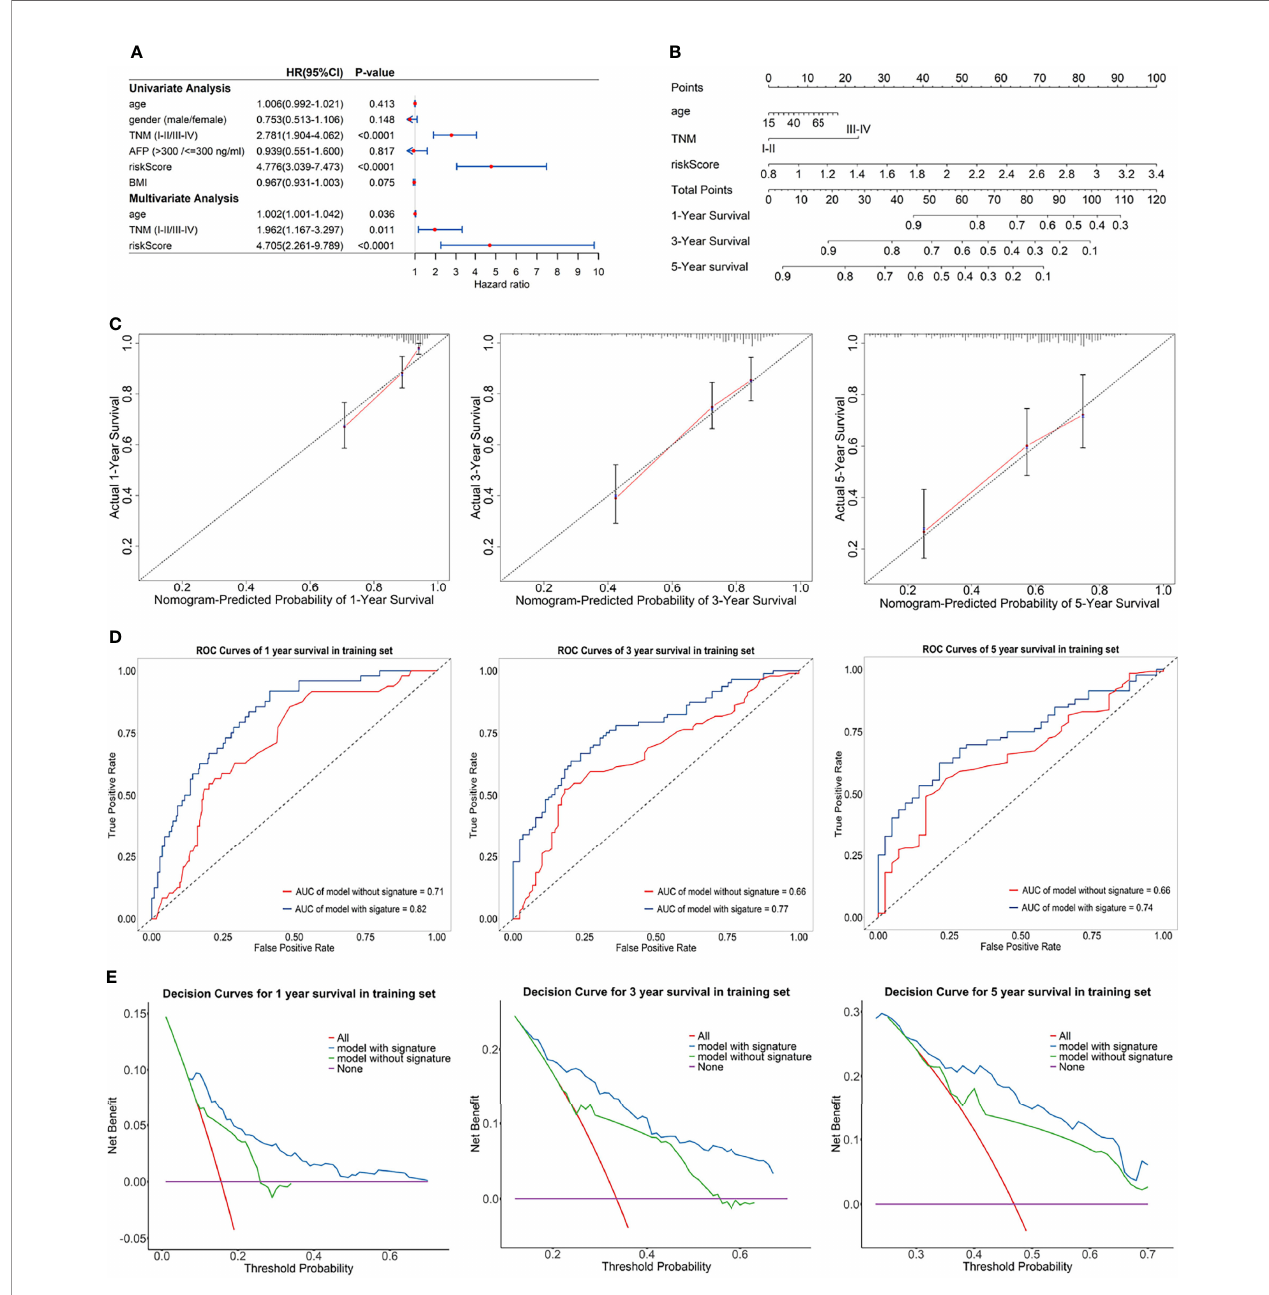
FIGURE 5 | (A) Forest plot for univariate Cox regression analysis and multivariate Cox regression analysis; (B) Nomogram predicting 1-, 3-, 5-year survival probability; (C) Calibration curves of the nomogram for 1-, 3-, 5-year overall survival in training set; (D) Time-dependent ROC curves of the nomogram for 1-, 3-, 5- year overall survival in training set; (E) DCA curves of the nomogram for 1-, 3-, 5-year overall survival in training